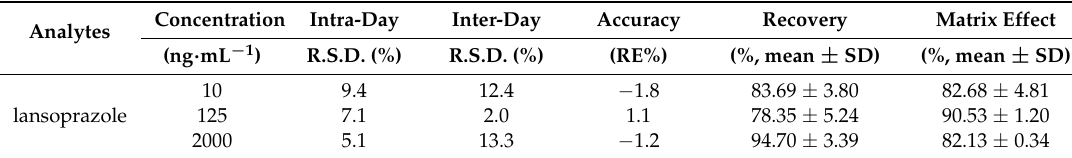
Table 4. Summary of accuracy, precision, recovery and matrix effects of the lansoprazole in dog plasma ( n = 6).